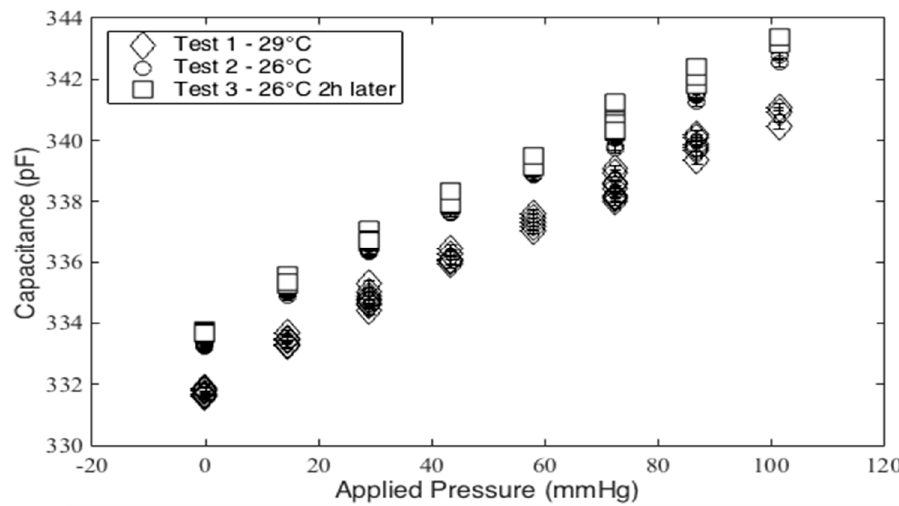
Figure 14. Capacitance vs applied pressure for various temperatures.